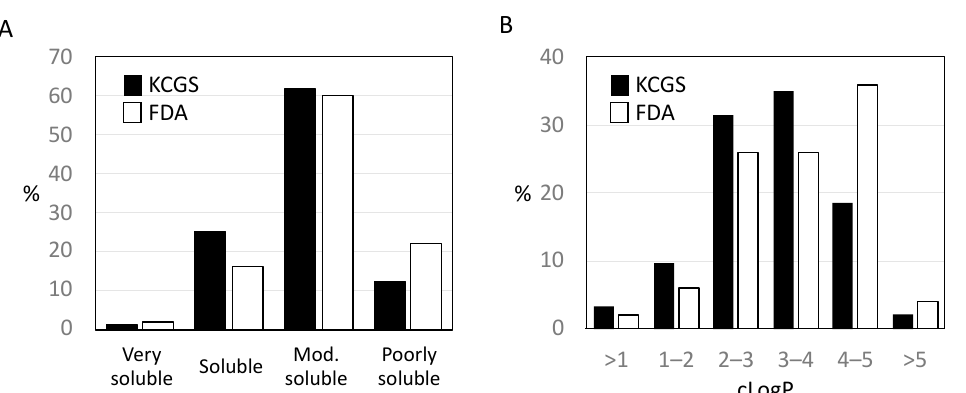
Figure 3. Calculated properties. ( A ) Predicted solubility of the KCGS compounds (black) compared to 52 FDA-approved kinase inhibitors (white) split into four categories and shown as percentage of the set. ( B ) Hydrophobicity analysis of the KCGS compounds (black) using SwissADME compared to the FDA-approved kinase inhibitors (white) split into six ranges of cLogP and shown as percentage of the set.